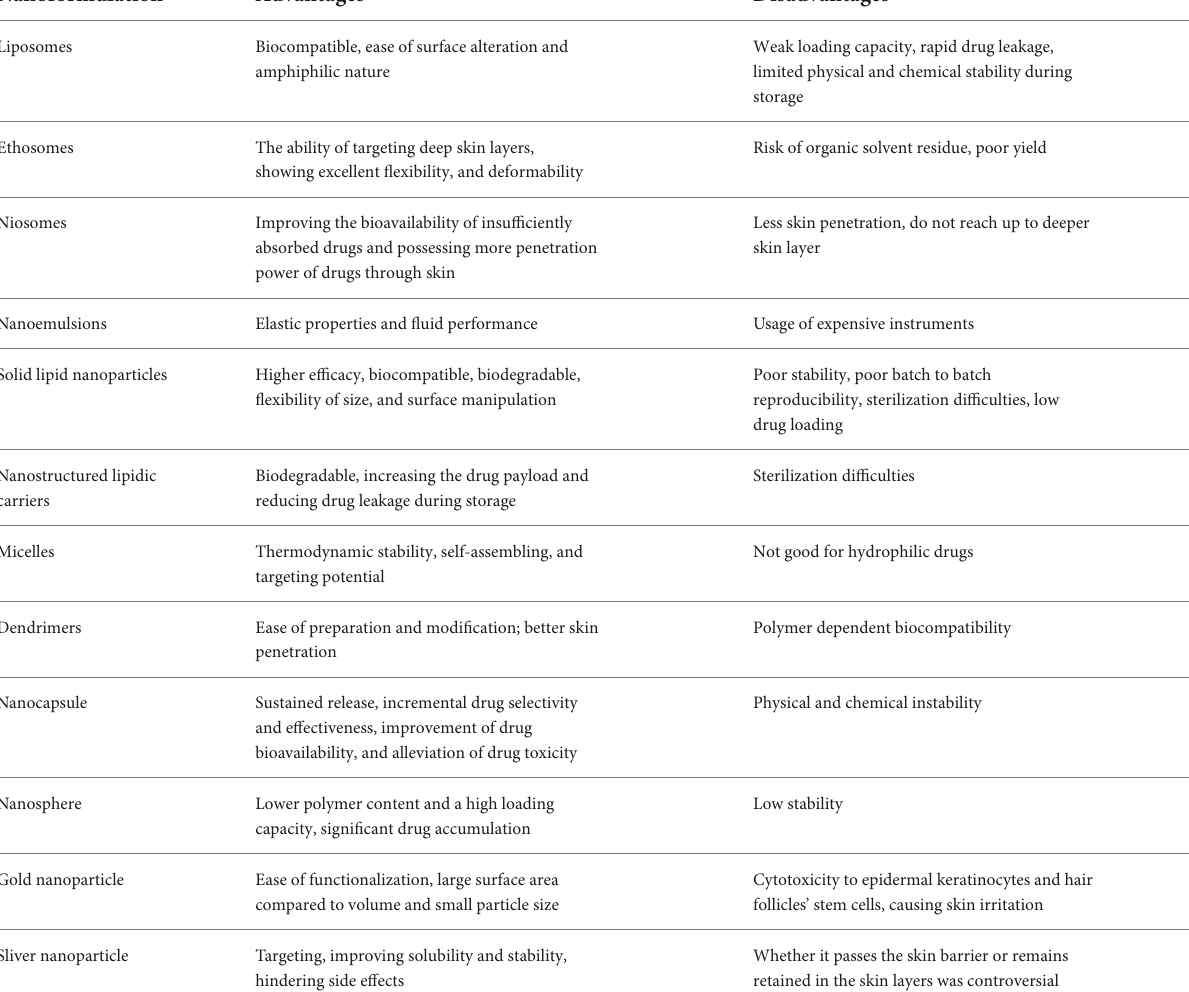
TABLE 1 The advantages/disadvantages of nanocarriers for the treatment of